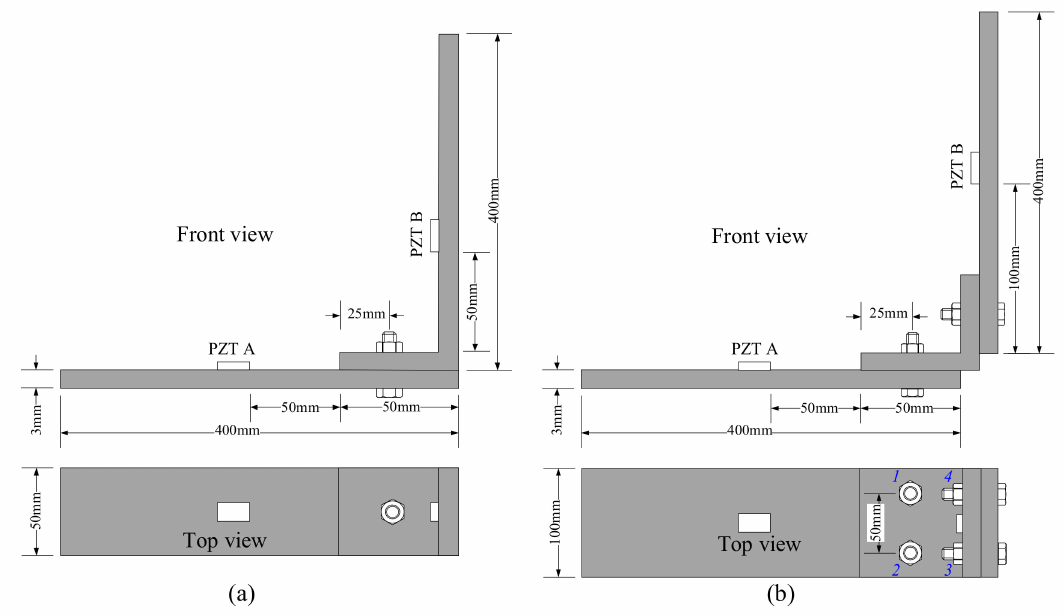
Figure 4. Schematic of experimental specimens ( a ) single bolt structure; ( b ) four-bolt structure.